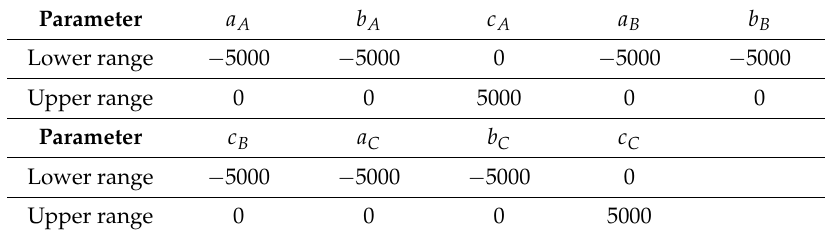
Table 5. The search boundaries of the coefficients related with the vertical movements.